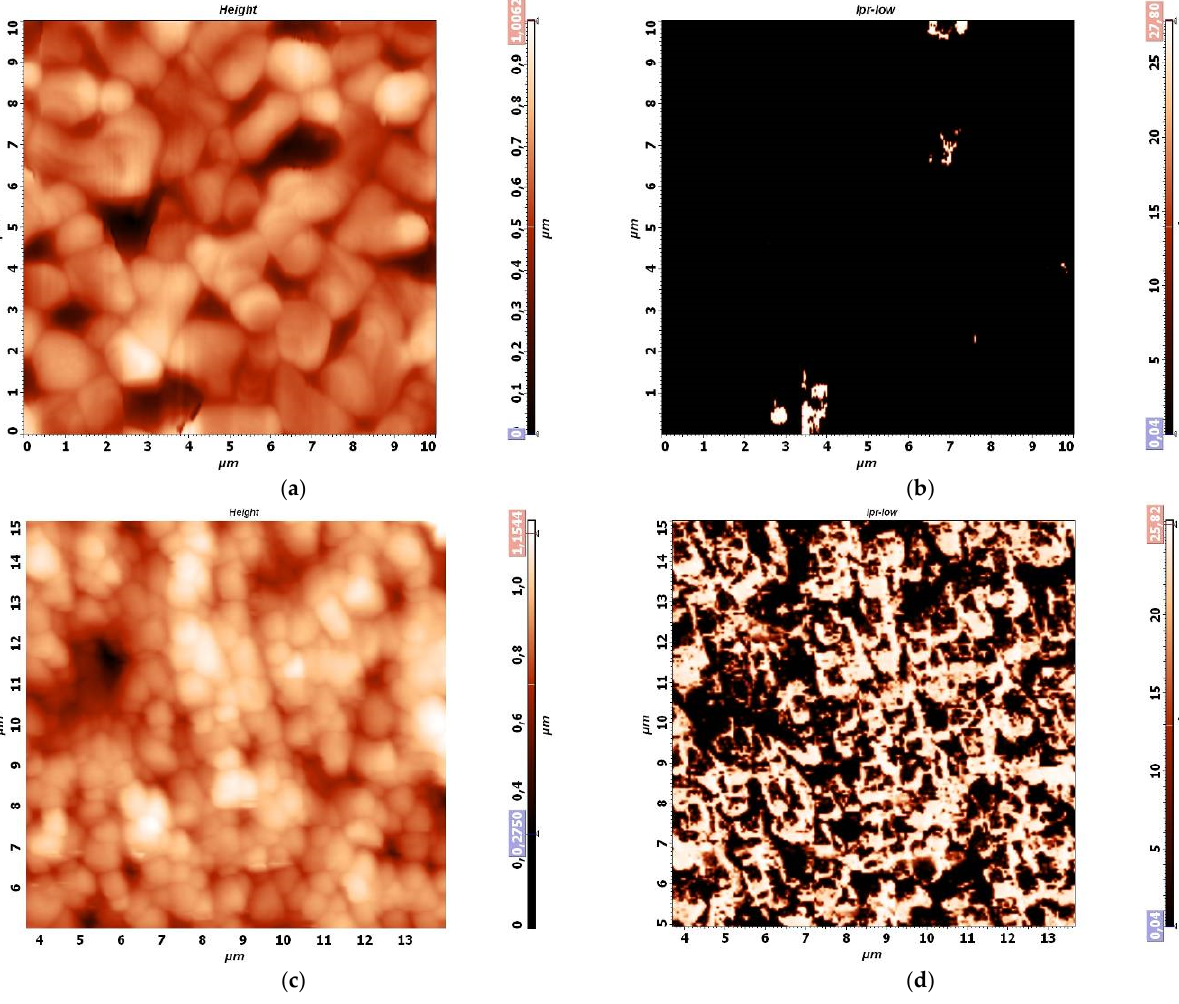
Figure 3. Topography ( a ) and conductivity map ( b ) of the oxidized PbCdSe layer (under applied voltage is applied U = 5 V). ( a ), topography ( c ) and conductivity map ( d ) of the PbCdSe layer after removal of the oxidizing coating (when an external voltage is applied U = 2.5 V).